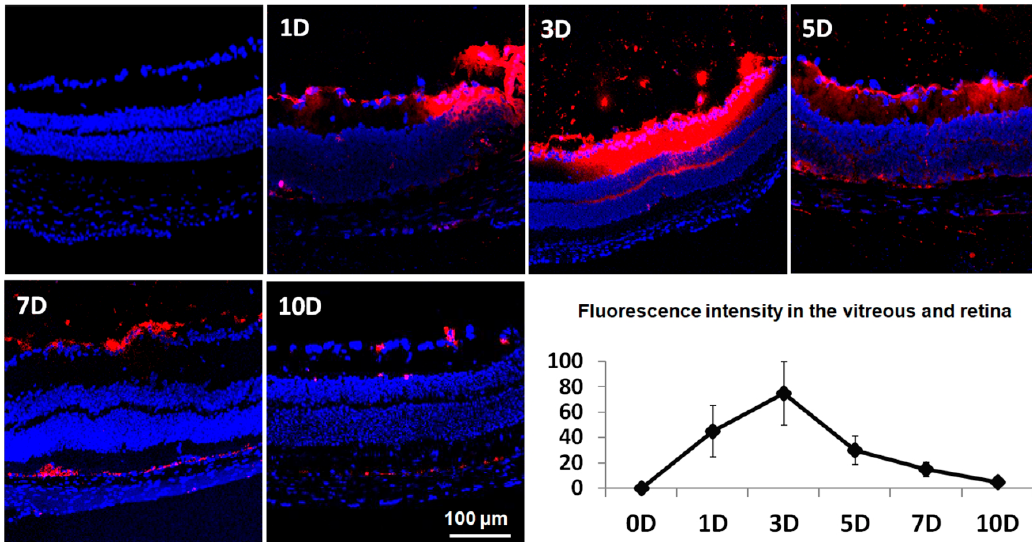
Figure 4. Temporal distribution of intravitreally injected liposomes. Images with lower magnification of the central retina including optic nerve head are presented in Supplementary Figure S1. Fluorescence microscopic images of the retina and fluorescence intensity at different time points after intravitreal injection of liposomes loaded with lipophilic fluorescence dye (red) are presented. The fluorescence intensity peaked at 3 days postinjection and declined gradually over a period of 10 days. D = days; Blue color = 4 ′ ,6-diamidino-2-phenylindole (DAPI) staining of retinal cell nuclei; Scale bar = 100 μ m.